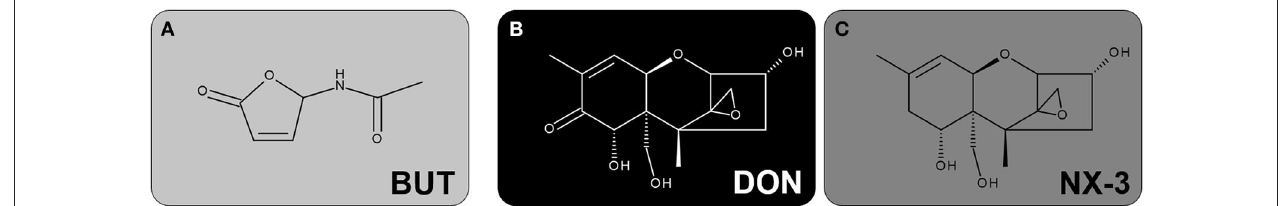
FIGURE 1 | Chemical structures of the investigated secondary metabolites of Fusarium : (A) BUT, (B) DON and (C)